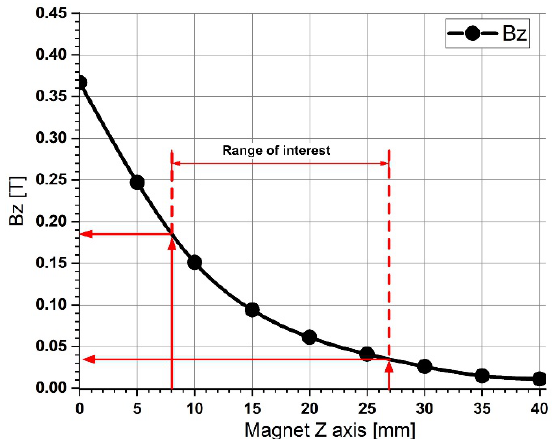
Figure 11. A magnetic field generated by the NbFeB52 permanent magnet, and field distribution at various Z -axis positions from the magnet surface, measured using an F.W. Bell Gaussmeter, model 5080.